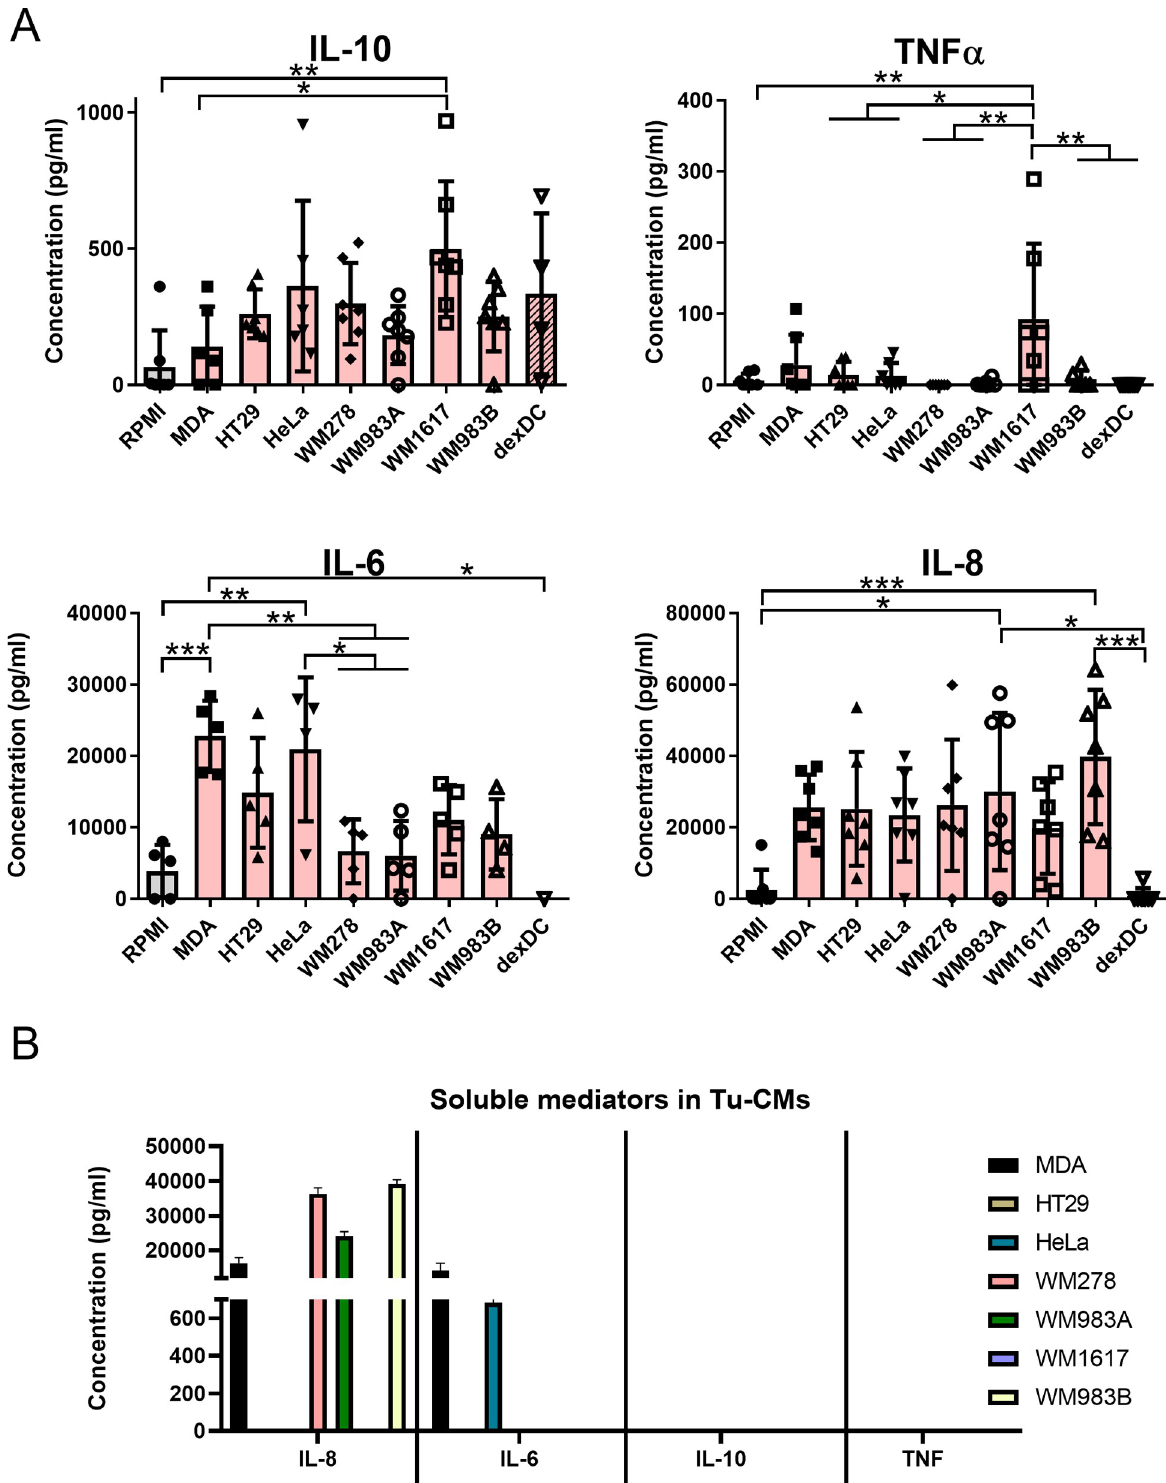
Fig 3. TU-CMs modulate the cytokine and chemokine production of moDCs. (A) CD14 + monocytes were cultured with 100 ng/ml IL-4, 80 ng/ ml GM-CSF ± MDA-MB231-, HeLa-, HT29-, WM278-, WM1617-, WM983A- or WM983B-CM for four days. The concentration of cytokines secreted by the moDCs or (B) the cytokine/chemokine content and concentration of TU-CM conditioned media were detected by ELISA. Mean